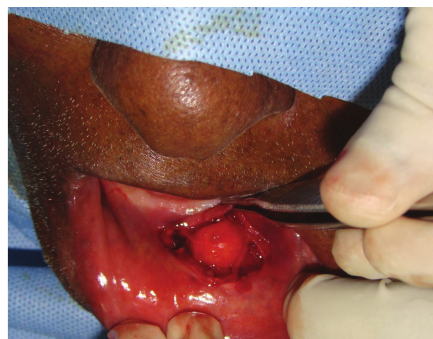
Figure 2: Exposed irregular, poorly encapsulated, and lobulated mass.